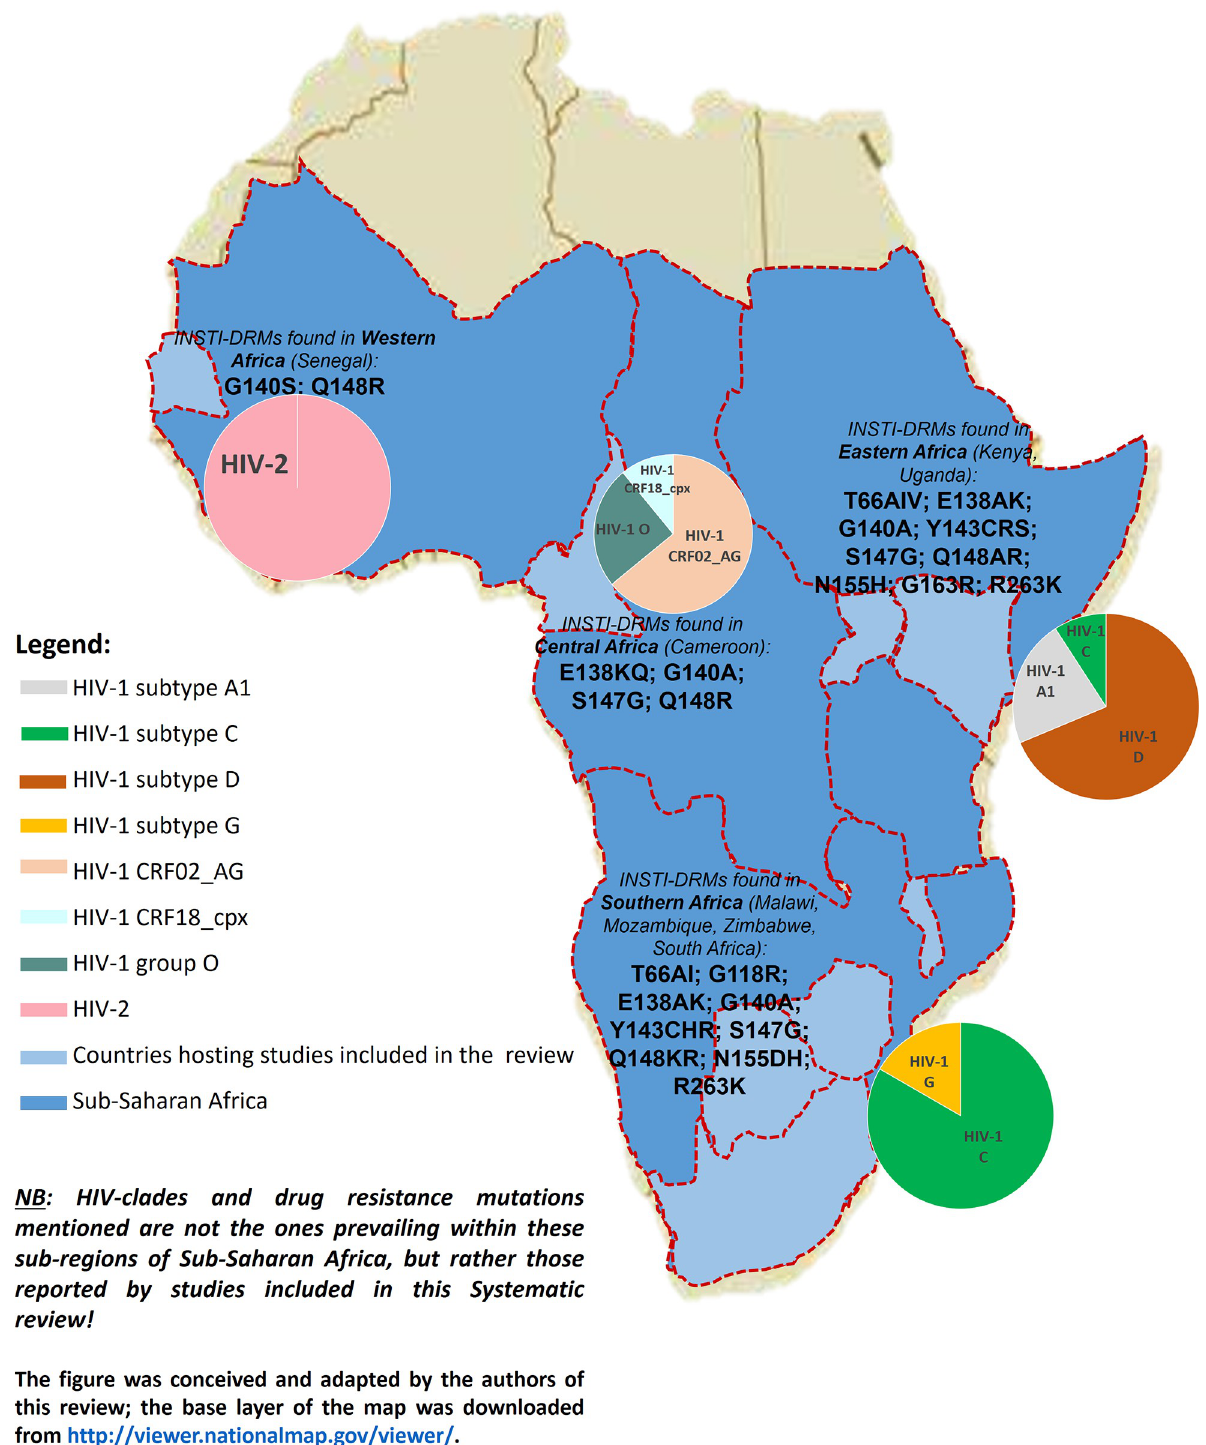
Fig 7. (a) The figure was conceived and adapted by the authors of this review; the base layer of the map was downloaded from http://viewer. nationalmap.gov/viewer/. (b) 2022 Semengue et al. This is an open access article published under the Creative Commons Attribution (CC BY)